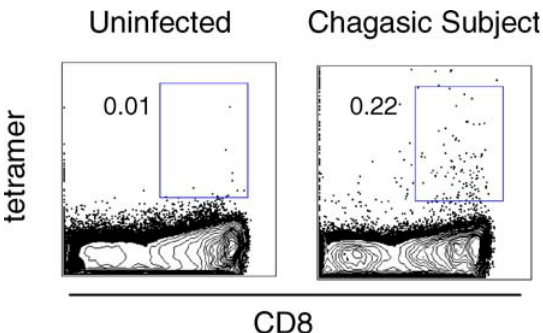
Figure 4. Detection of CD8 þ T Lymphocytes Recognizing HLA-A2.1– Restricted ts Epitopes in Patients with Chronic Chagas Disease PBMCs were stained using MHC tetramers specific for the TSA2–38 or TSA2–44 epitopes. The percentage of CD8 þ T cells staining positive for TSA2–38 is shown for a representative chronic chagasic patient and an uninfected control. Cells shown are lymphocytes gated on CD4 neg B220 neg CD11b neg lymphocytes. Five out of eight IFN c ELISPOT þ subjects stained positive with